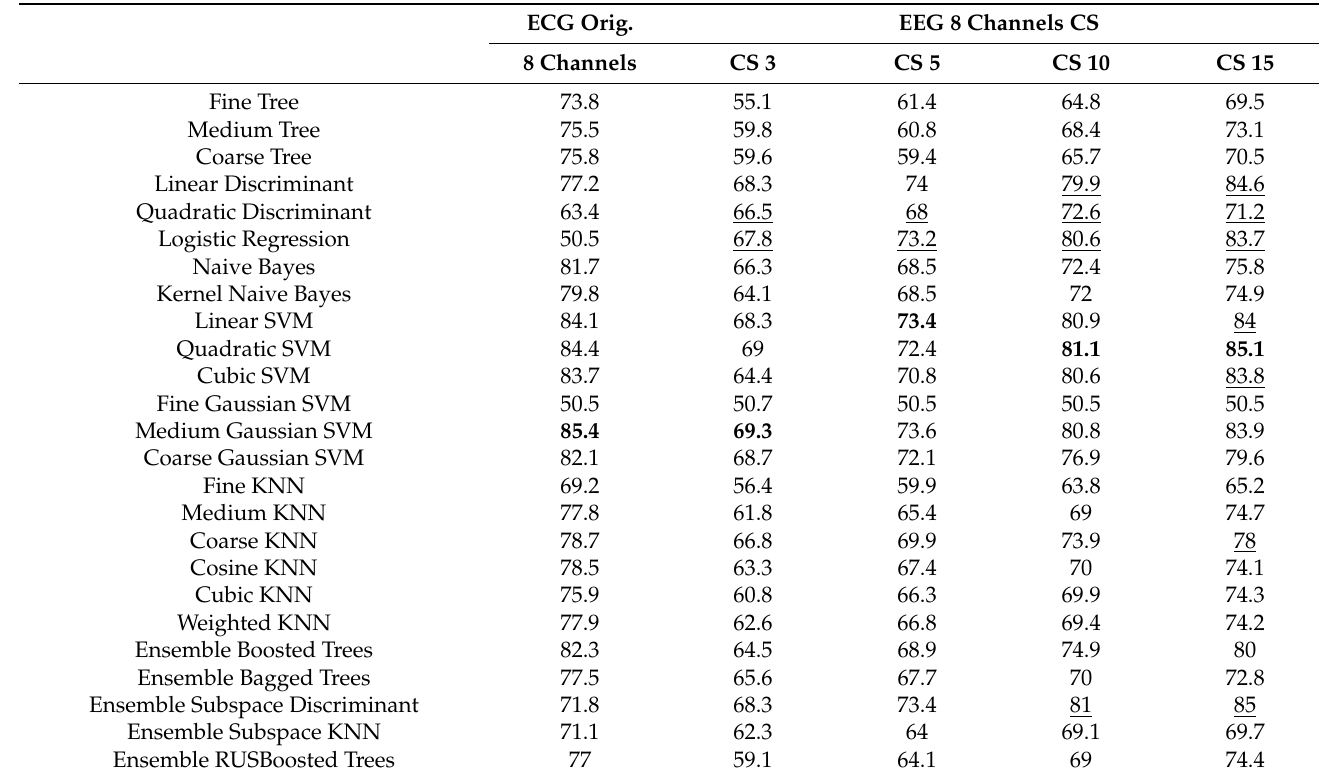
Table 5. Classification results with CS method for configurations with 8 channels. ECG